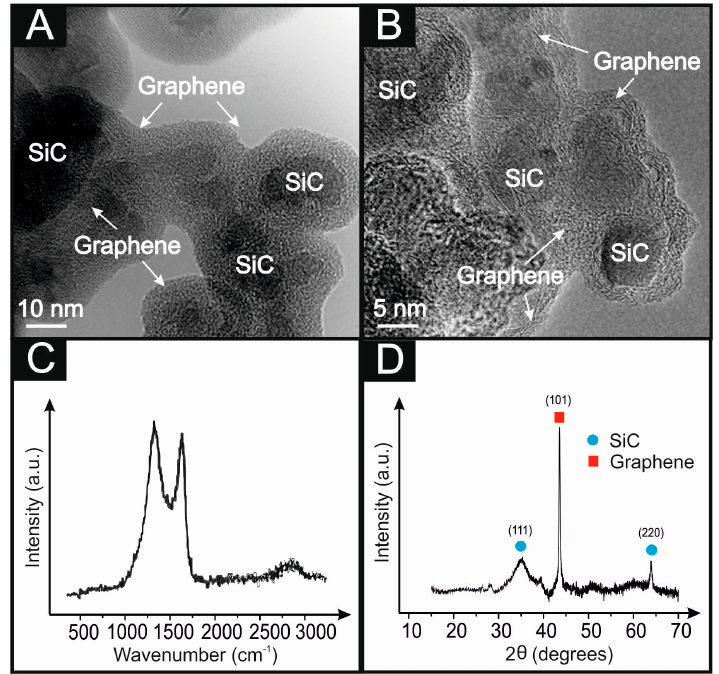
Figure 1. Transmission electron microscopy (TEM) ( A , B ) imaging, Raman ( C ), and X-ray diffraction (XRD) ( D ) analysis of the graphene@SiC.